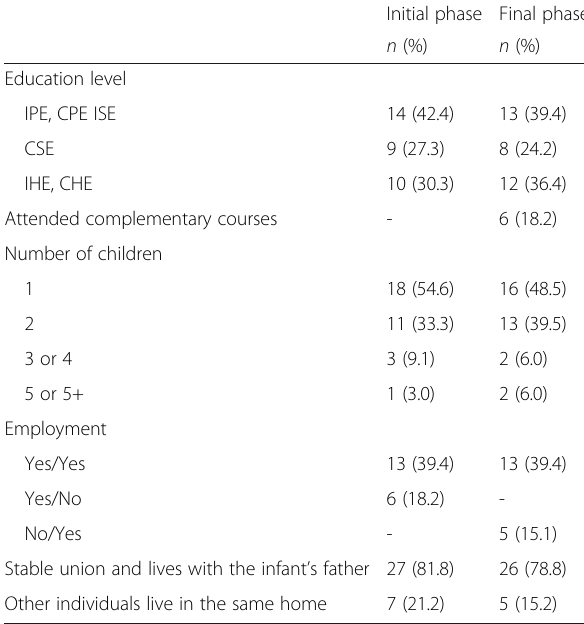
Table 1 Participants ’ description during the initial and final phases of the longitudinal study